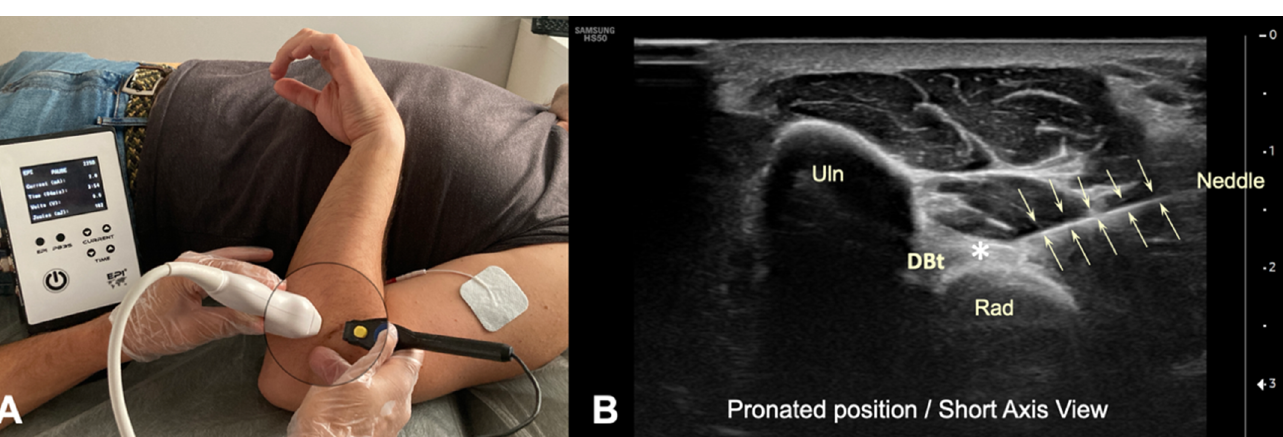
Figure 4. ( A ) Illustration of the percutaneous electrolysis approach with the elbow flexed and pronated in “Cobra position”; ( B ) US imaging of the needle inserting into the distal biceps tendon in short axis, with the elbow flexed and pronated. (DBt)-Distal Biceps Tendon (Asterisk), (Uln)-Ulna, (Rad)-Radius).